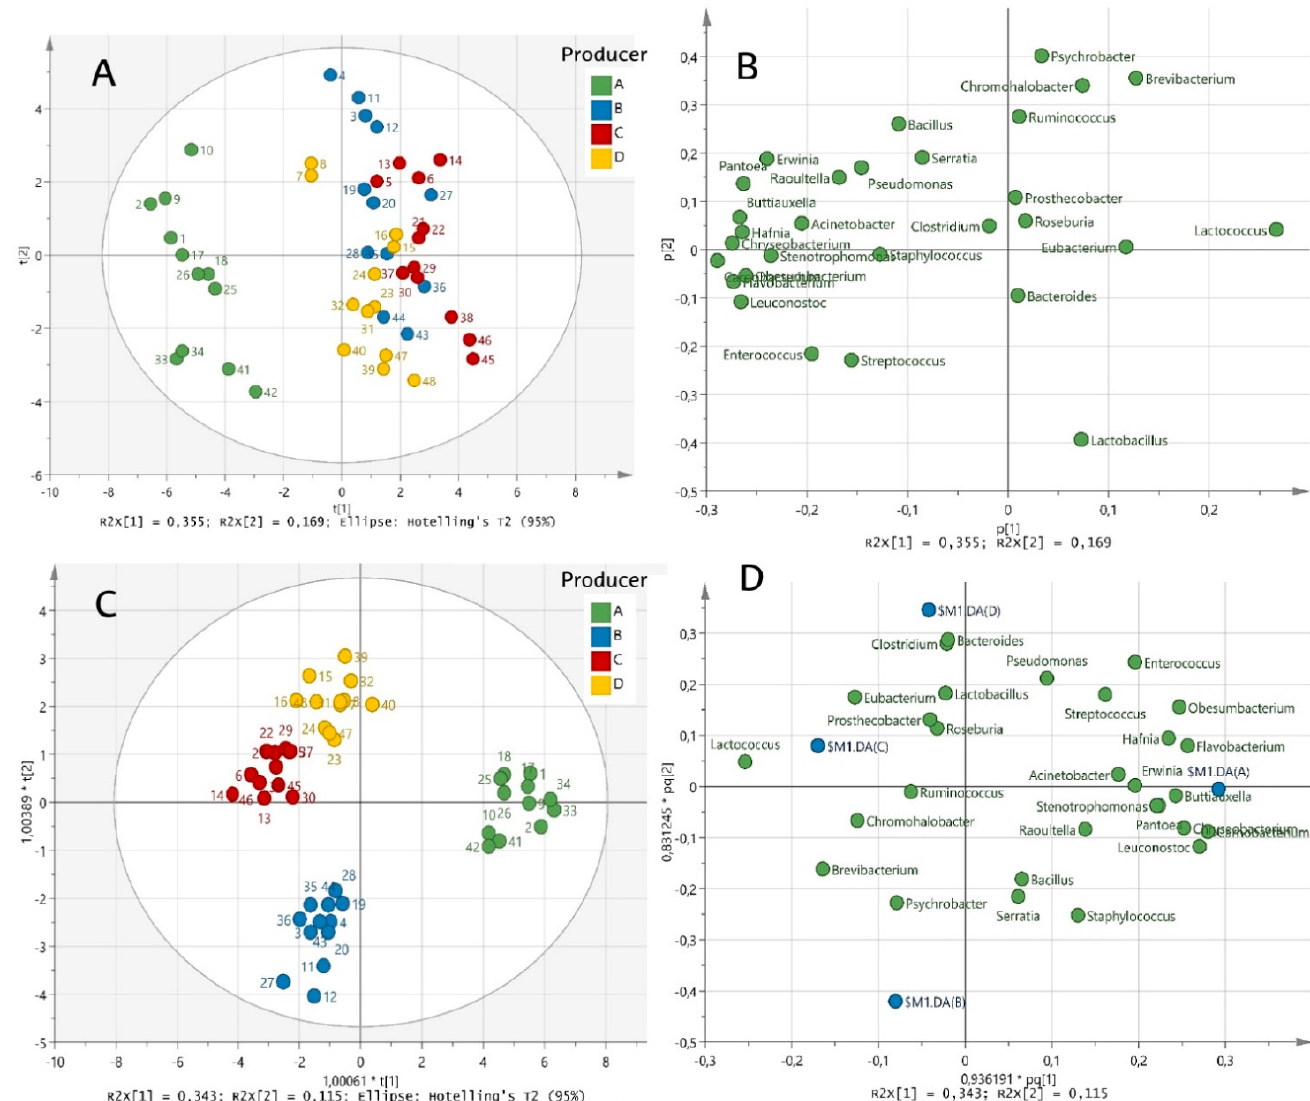
Figure 4. Scores and loadings plots of PCA (( A , B ), respectively) and OPLS-DA (( C , D ), respectively) based on main bacterial genera of Idiazabal cheese samples from four producers (A, B, C and D). Samples are coloured according to the producer and labels indicate samples ID.